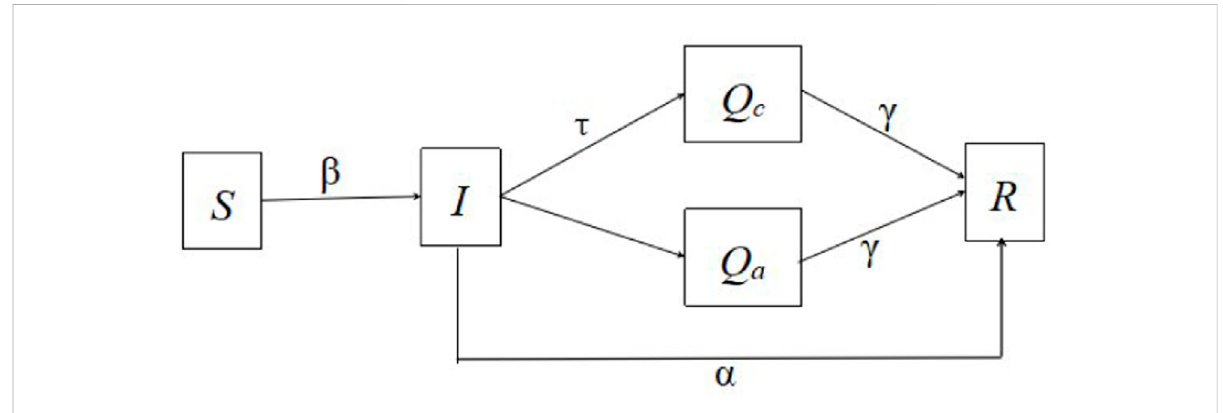
FIGURE 1 The schematic diagram of Model